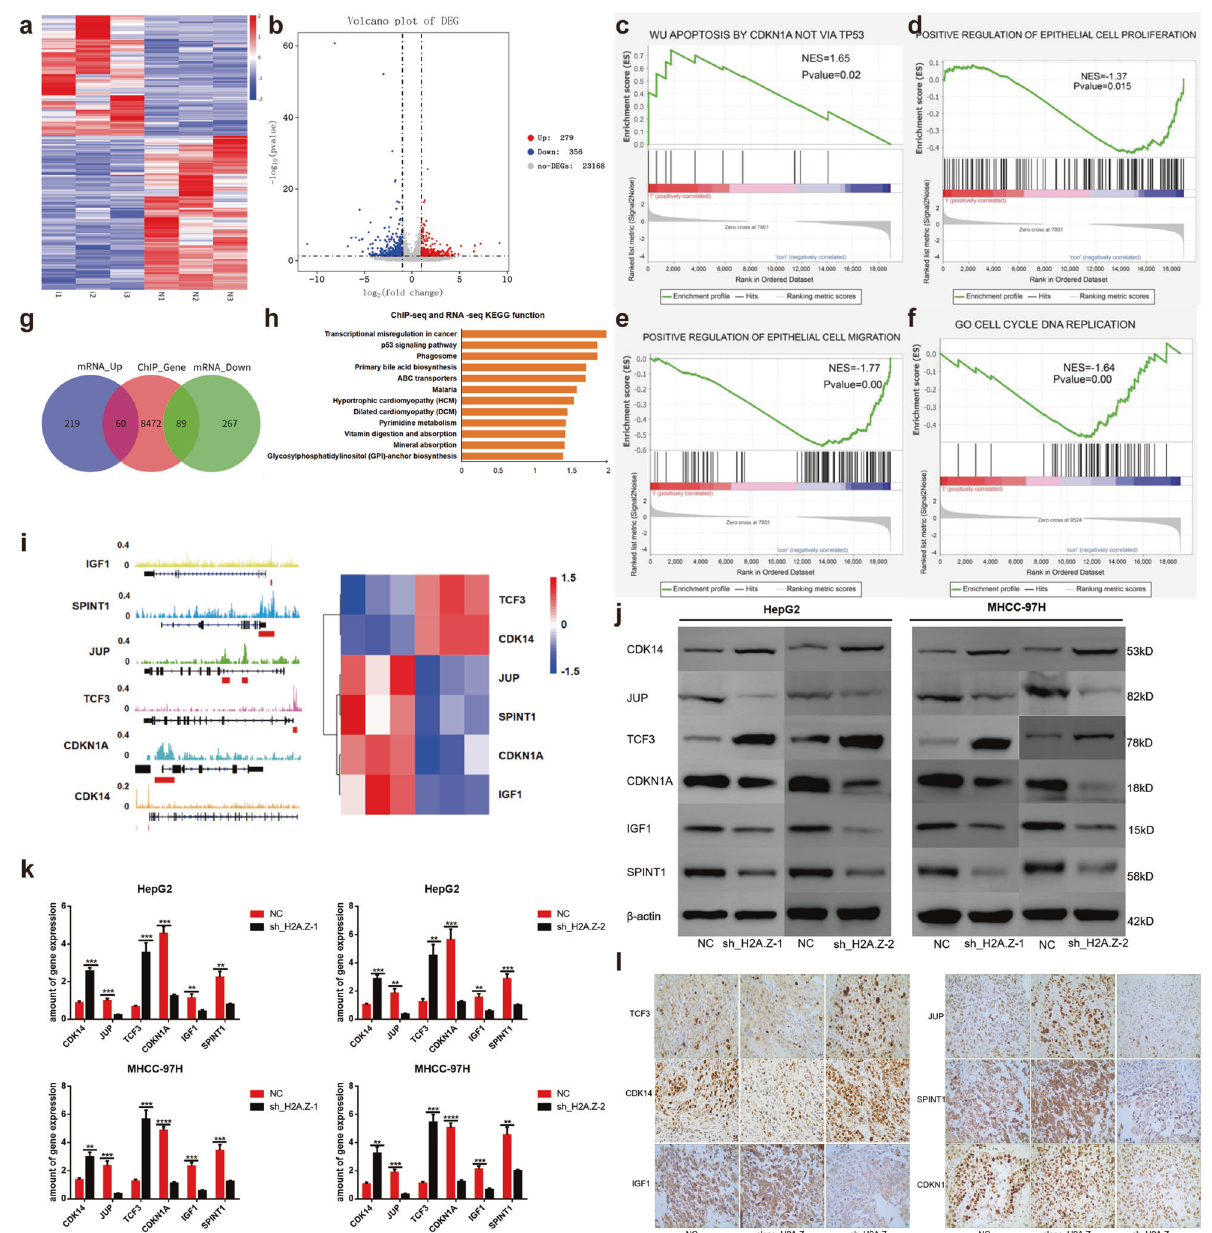
Fig. 3 H2A.Z plays a pro-tumor role through transcriptional misregulation in cancer signaling pathways. a Heat map of whole-gene transcriptomic changes detected by RNA-seq in HepG2 cells that knockdown H2A.Z expression(Software: R pheatmap, R package). b Volcanogram of changes at the whole-gene transcriptomic level in HepG2 cells that knockdown H2A.Z expression(Software: ggplot2, R package). c – f Enrichment of pathway in GSEA analysis of genes altered as described above (Software: GESA). g Venn diagram depicting the overlapping variation genes in RNA-seq and Chip-seq of H2A.Z(Software: Venn Diagram, R package). h KEGG pathway analysis was used to analyze the combined analysis results showed that H2A.Z might be associated with transcriptional misregulation in cancer signaling pathway in HCC cells (Software: ggplot2, R package). i IGV diagram of the downstream target gene of H2A.Z in the combined analysis data. j , k Changes in the expression of target genes upon H2A.Z were knockdown in HCC cells detected by qPCR and western blot. l Immunohistochemical analysis of target proteins in tumors in nude mice from different groups(Scale bars: 20 μ m). The data are expressed in terms of mean ± SD (Student ’ s t -test used in Fig k ; ** P < 0.01; *** P < 0.001. **** P < 0.0001; n = 3 in each